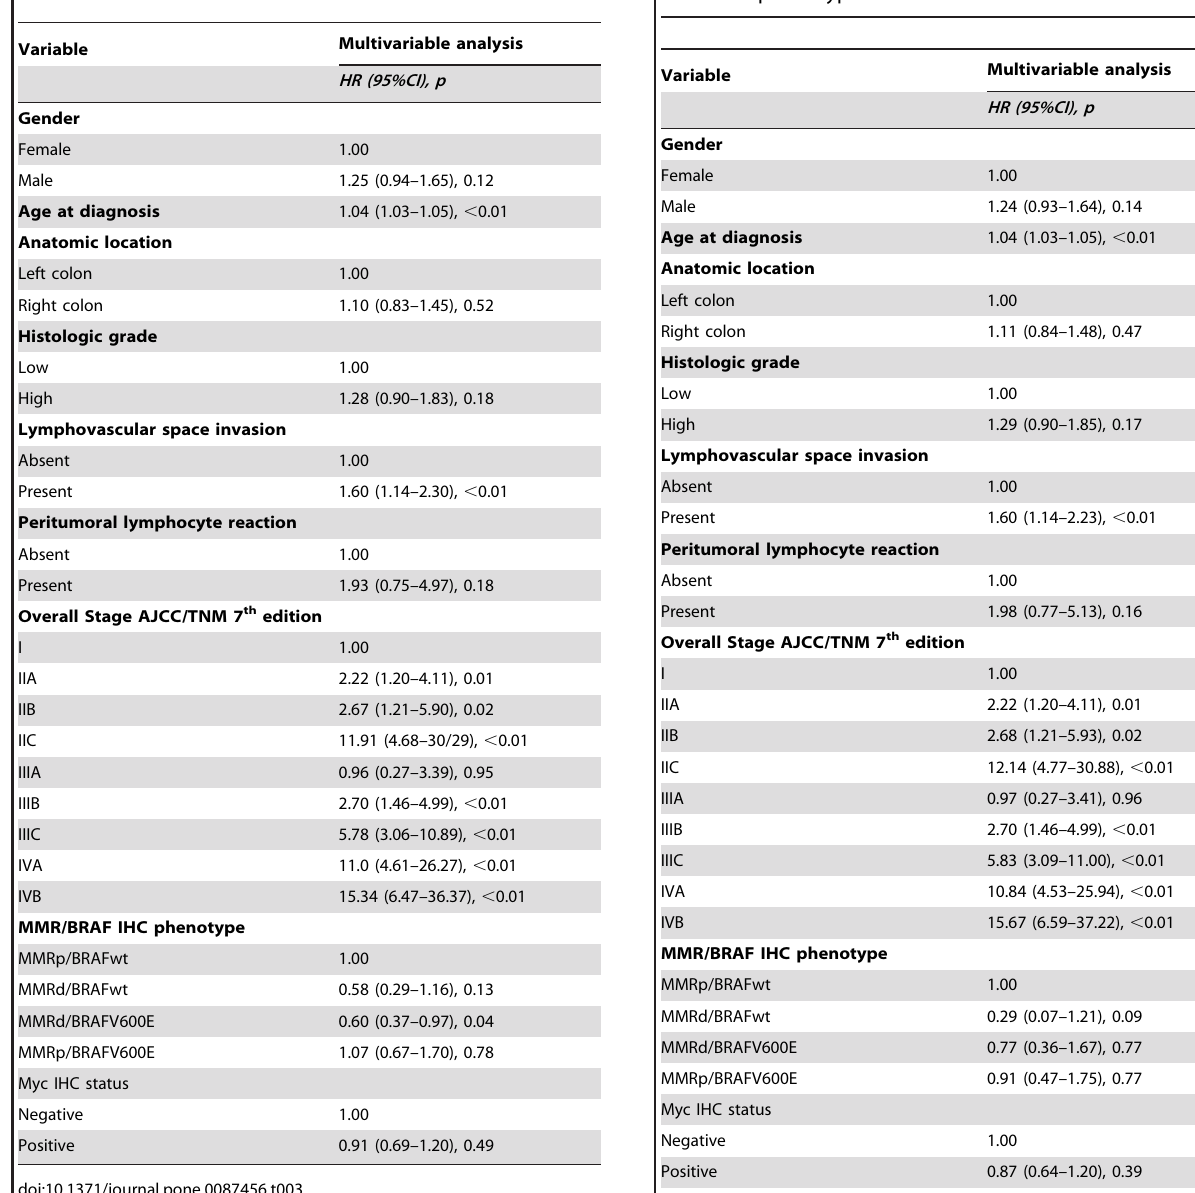
Table 3. Multivariable Cox regression proportional hazards analysis of 1421 CRCs.